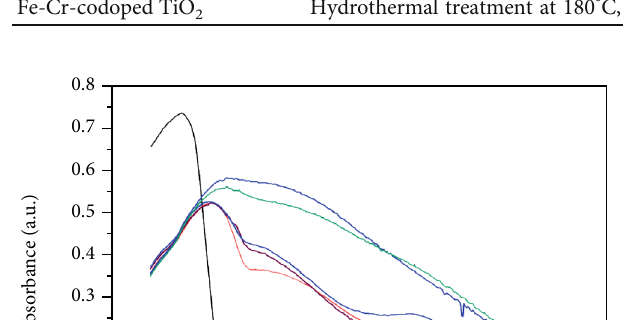
, TiO -1%Co, TiO - 2 2 2 -2.5%Co- 2